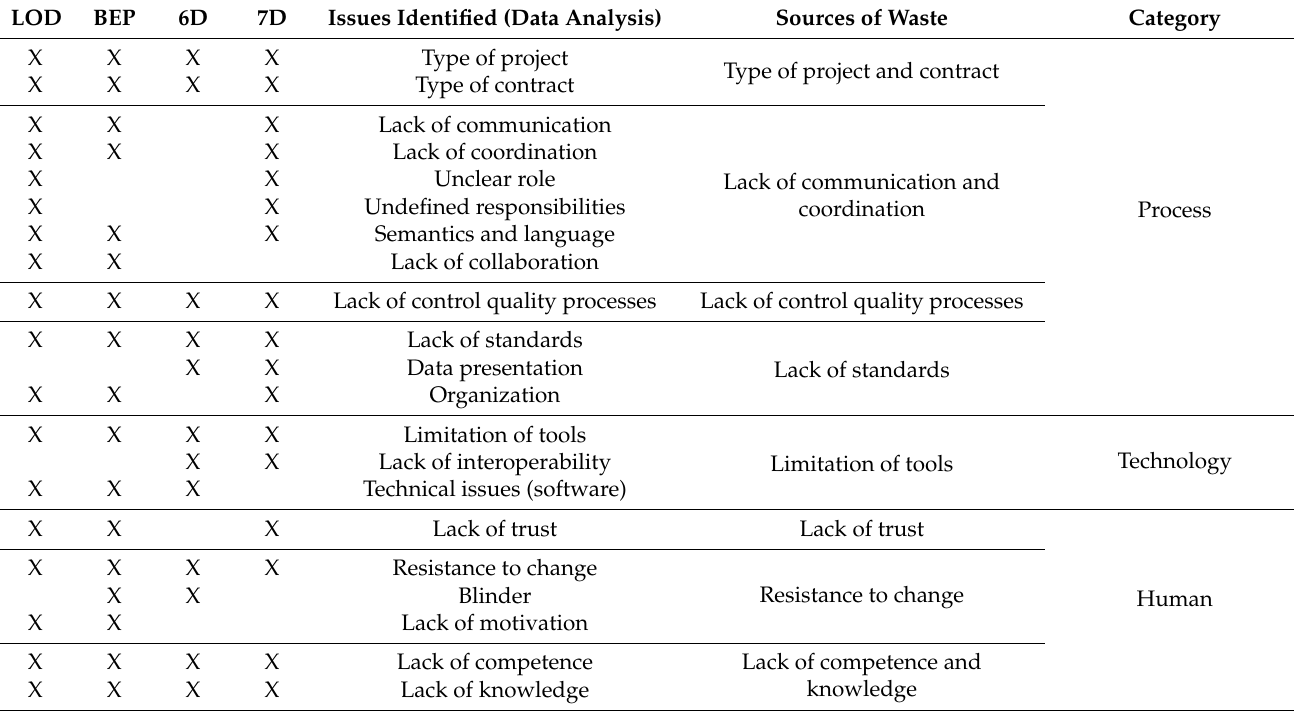
Table 2. Sources of waste identified in the information flows through data